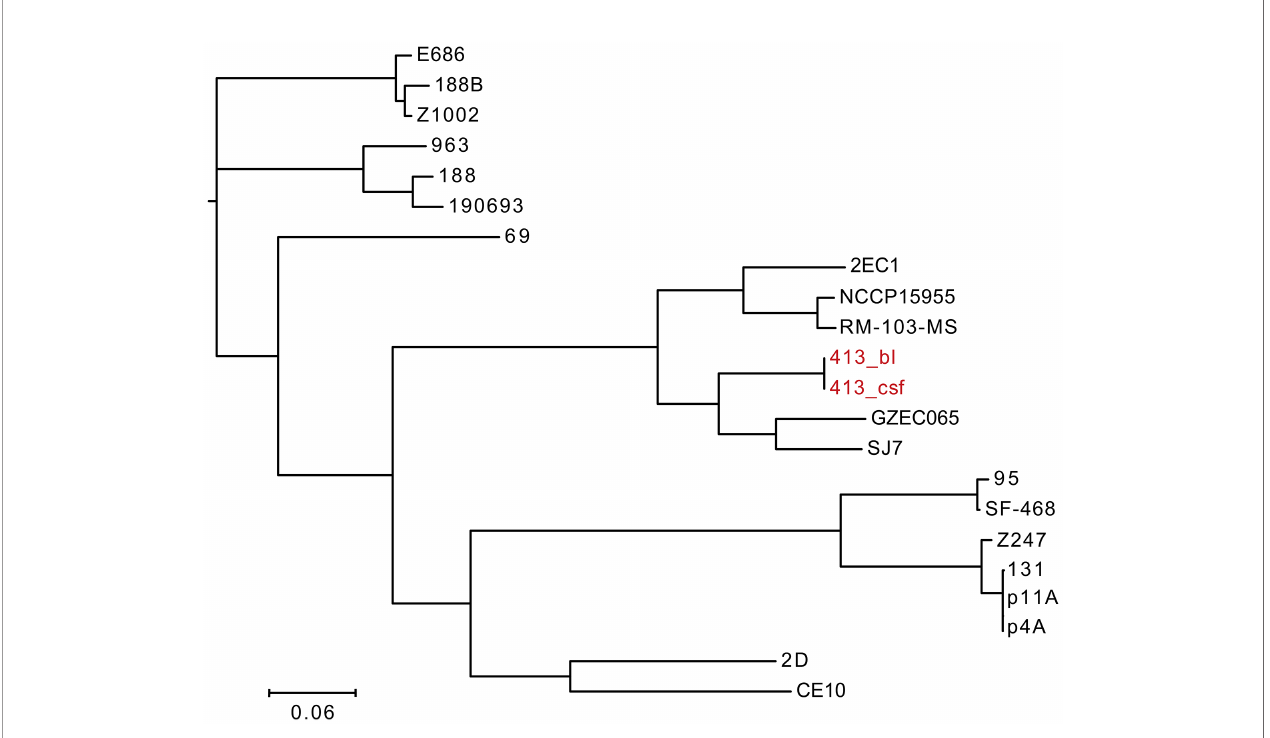
FIGURE 4 | Phylogenetic tree constructed using whole genomes of 22 E. coli strains, including E. coli 413_bl strains isolated from bloodstream, E. coli 413_csf isolated from cerebrospinal fl uid, and 20 E. coli strains screened from the National Center for Biotechnology